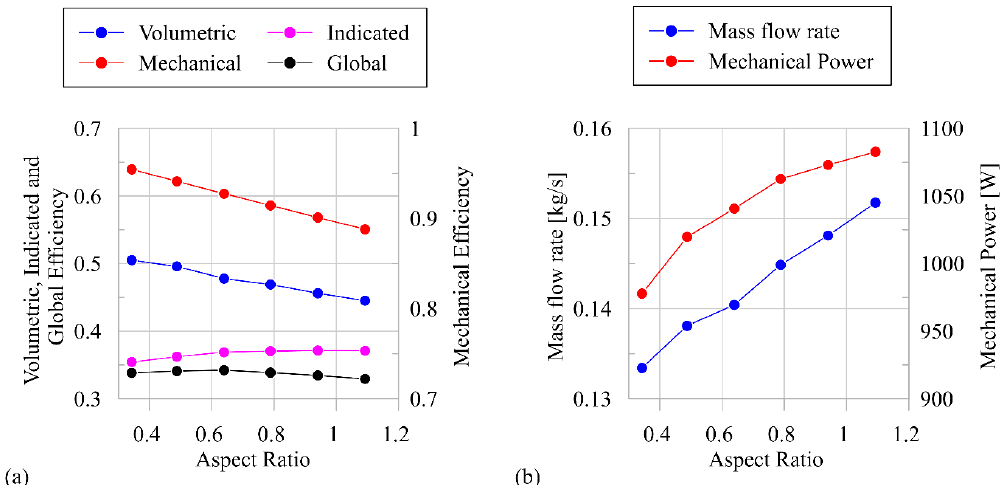
Figure 12. Results of the model-based design: global, volumetric, indicated and mechanical efficiency ( a ), mass flow rate and mechanical power ( b ). The rotor diameter was fixed to 65 mm.